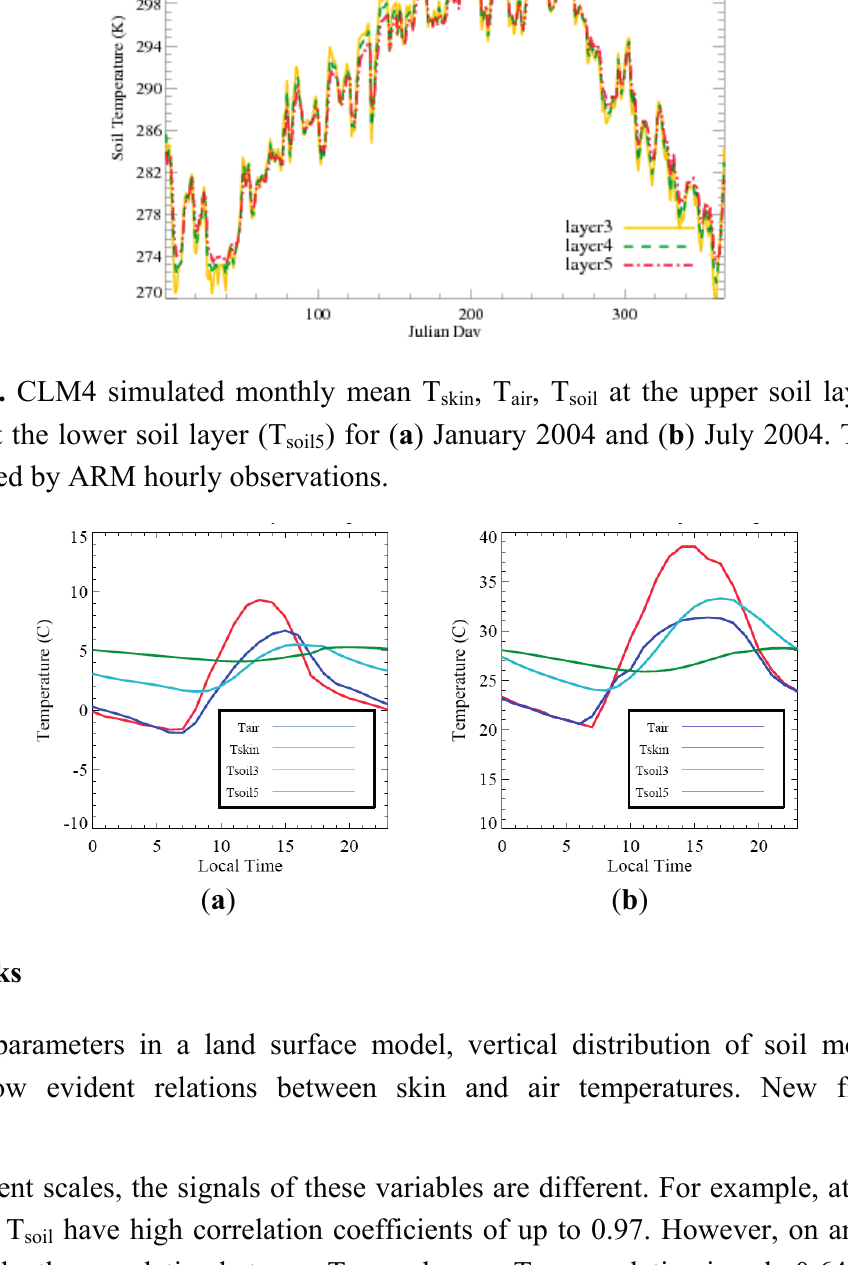
Figure 9. Offline CLM4 simulated daily averaged soil temperature at the upper soil layer (model layer 3, − 0.05 m), the middle layer (model layer 4, − 0.12 m) and the lower layer (model layer 5, − 0.25 m). The model run uses ARM hourly atmospheric forcing for Year 2004.